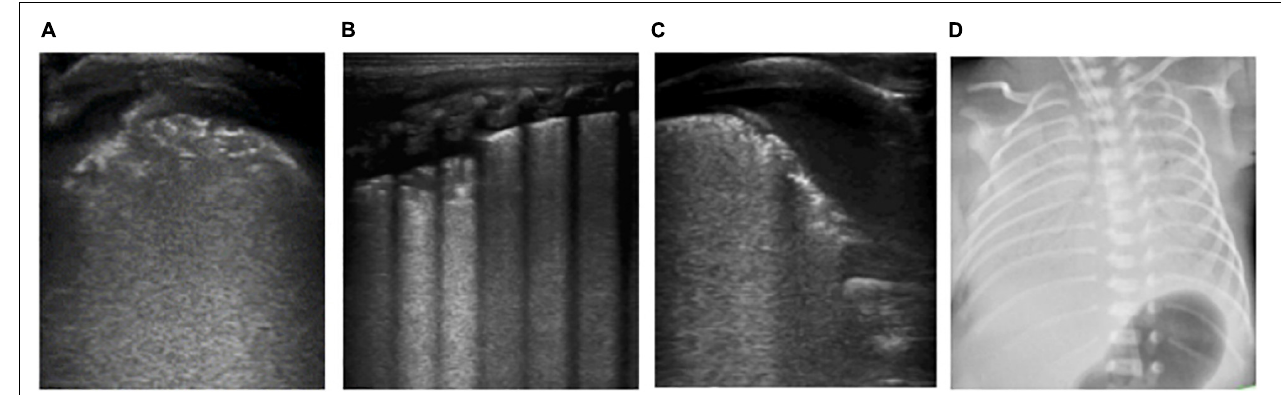
FIGURE 2 | The patient is a twin neonate born at 32 weeks of gestational age by Cesarean section due to “fetal distress” with clear amniotic fluid and the Apgar score of 1, 5, and 10 min of birth were 5, 7, and 7 points. After delivery, the neonate had cyanosis, labored breathing, and severe pulmonary hypertension, and high-frequency ventilation was performed. It was diagnosed as neonatal respiratory distress syndrome (RDS). (D) Chest X-ray: White lung changes. (A–C) LUS: Abnormal pleural line, the disappearance of A-lines, white lung change, snowflake sign, such as air bronchogram visible below pleura, which conforms to the ultrasonic characteristics of severe RDS.